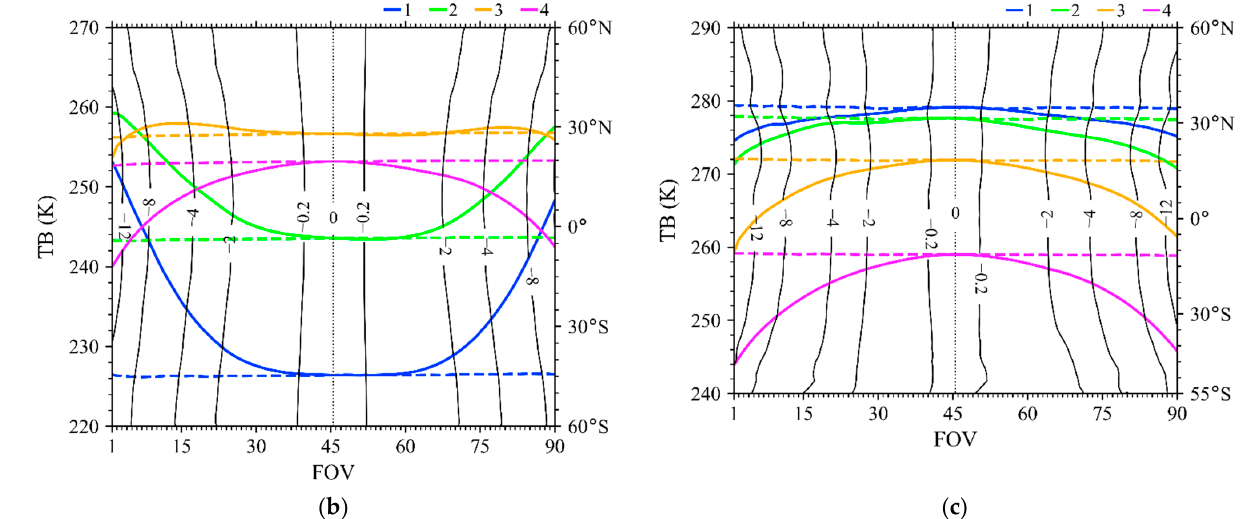
Figure 3. Mean scan dependences of FY-3D MWTS-2 brightness temperature observations ( Y -axis on the left) before (colored solid curves) and after (colored dashed curves) the limb correction ( a ) of channels 5–13 globally and ( b , c ) of channels 1–4 over ( b ) sea and ( c ) land within (60 ° N–60 ° S, 180 ° W–180 ° E). Thin black contours are limb correction values ϕ of ( a ) channel 6 and ( b , c ) channel 4 as a function of scan position and latitude at 2 ° intervals. Limb correction is conducted on observations from 21 to 30 June 2019 with correction coefficients trained with observations from 10 to 20 June 2019.